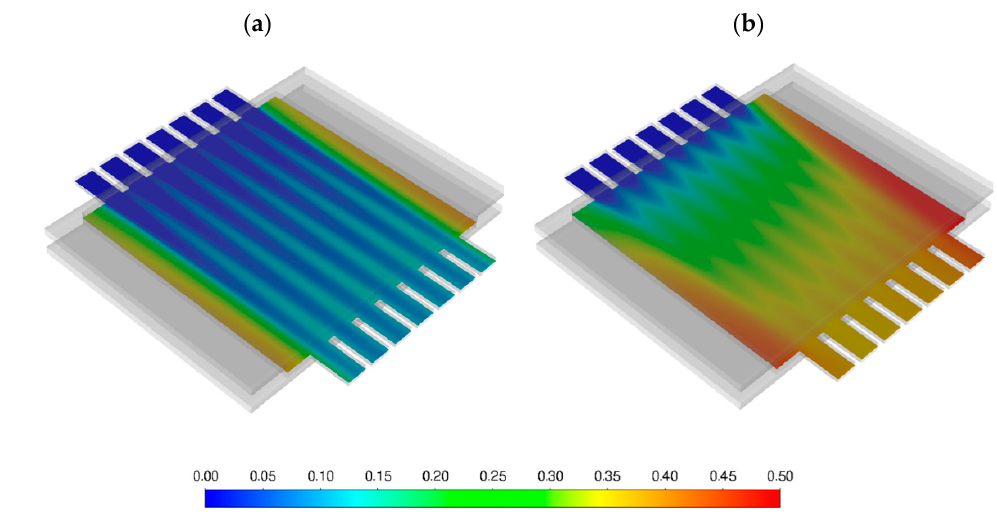
Figure 17. Contours of O 2 molar fraction, v sweep = 1 m/s ( a ), 0.1 m/s ( b ).